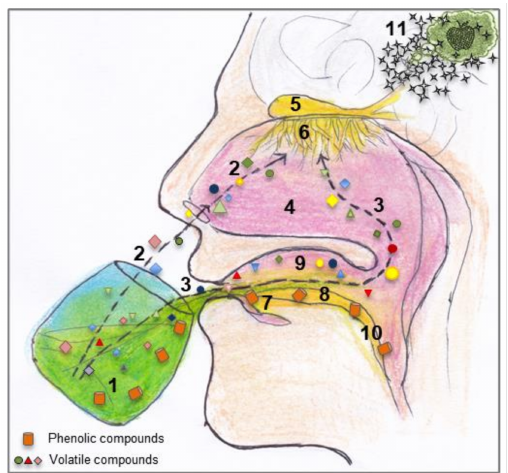
Figure 1. Schematic diagram representing virgin olive oil flavor perception. Legend: (1) extra virgin olive oil glass, (2) odor (through ortho-nasal route), (3) aroma (through retro-nasal route), (4) nasal cavity, (5) olfactory bulb, (6) olfactory epithelium (sense of smell), (7) tongue (sense of taste), (8) taste buds (bitterness perception), (9) oral cavity, (10) trigeminal nerve (chemesthesis perception: pungency), and (11) signal in the brain and the recognition of sensory perception (adapted from Genovese and Sacchi